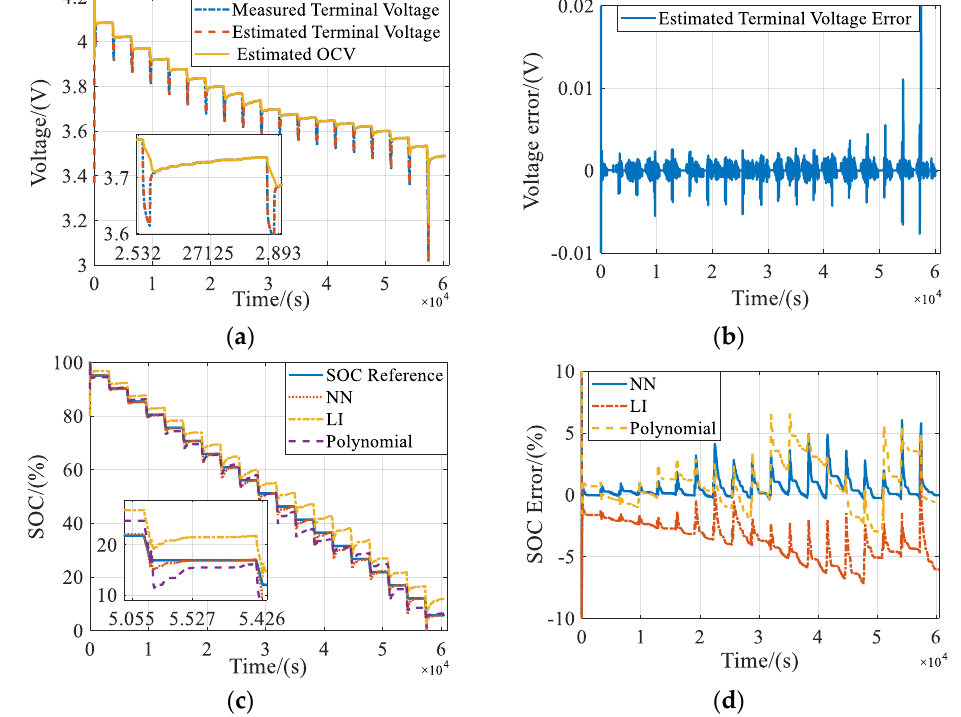
Figure 7. Comparison of different OCV construction methods in pulse constant current discharge test. ( a ) Terminal voltage and OCV estimation result. ( b ) Estimation error of terminal voltage. ( c ) Comparison of SOC estimation result. ( d ) Comparison of SOC estimation error. Table 2. Comparison of SOC estimation error for different OCV Curves.